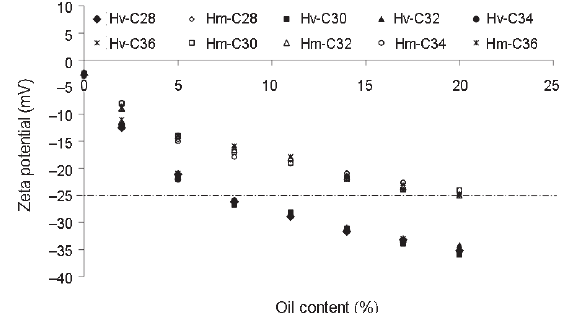
Fig. 16. Evolution of potential zeta as a function of oil content